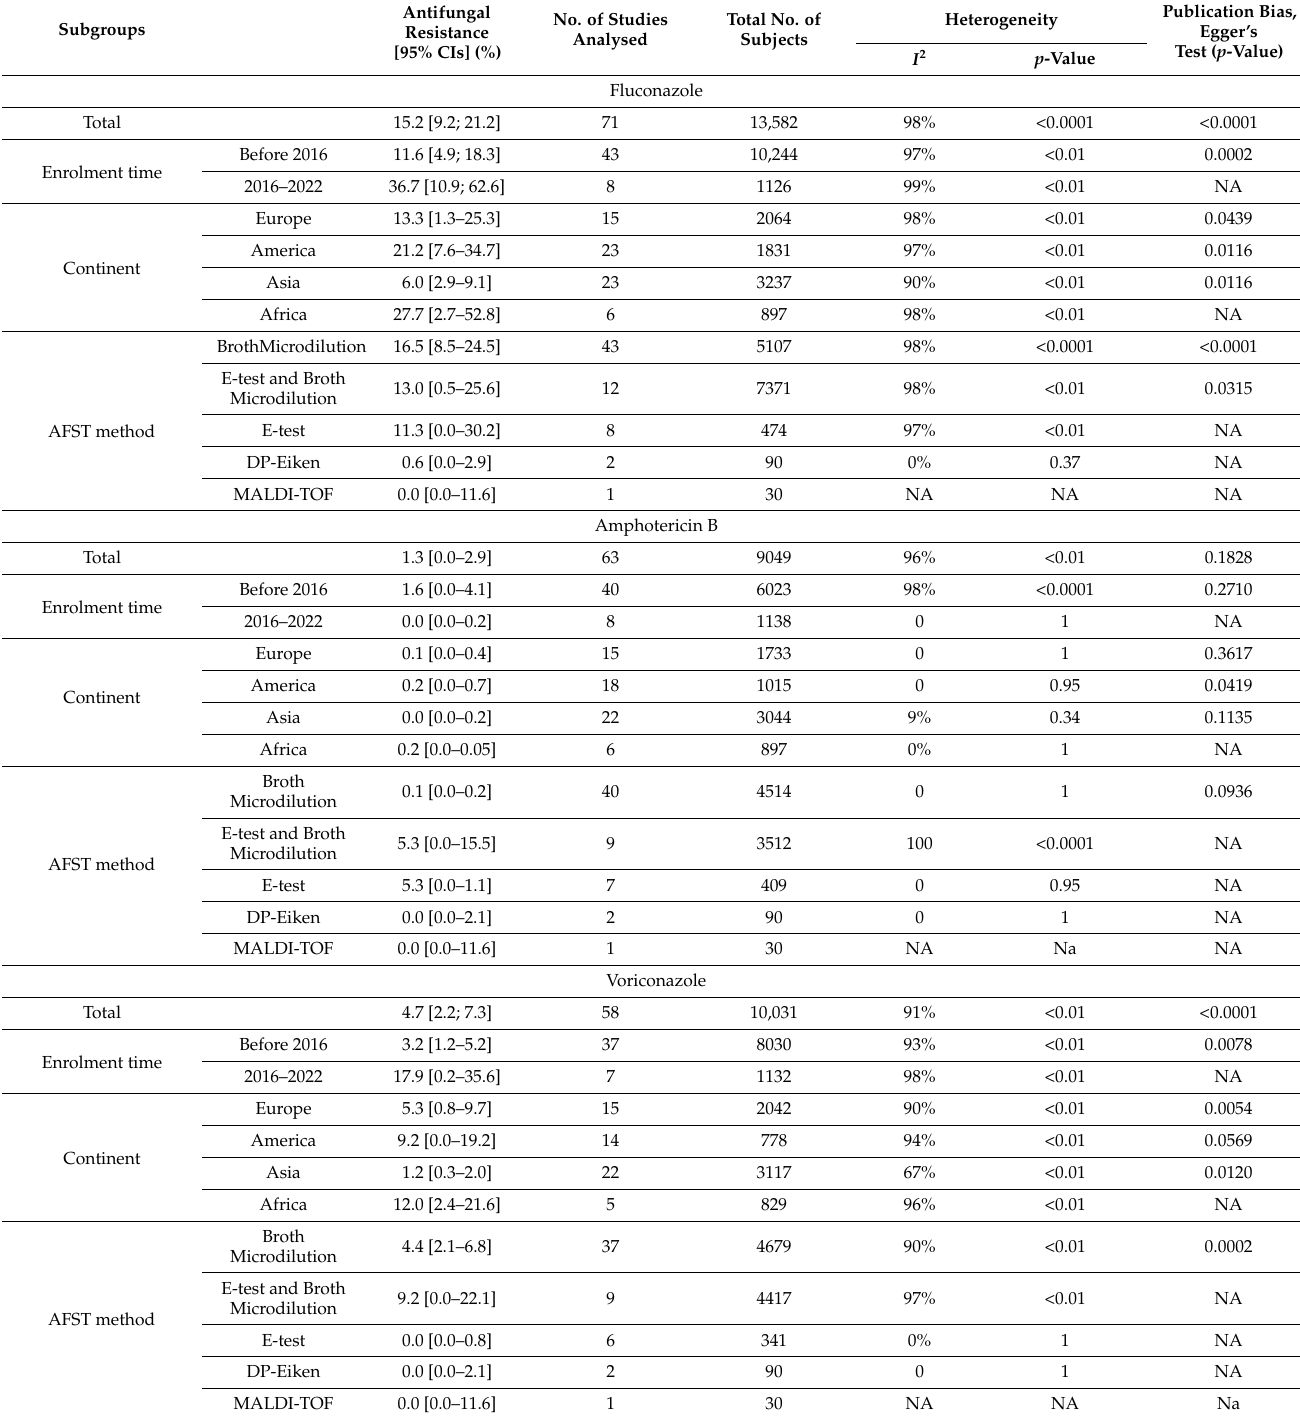
Table 2. Pooled C. parapsilosis antifungal resistance in different